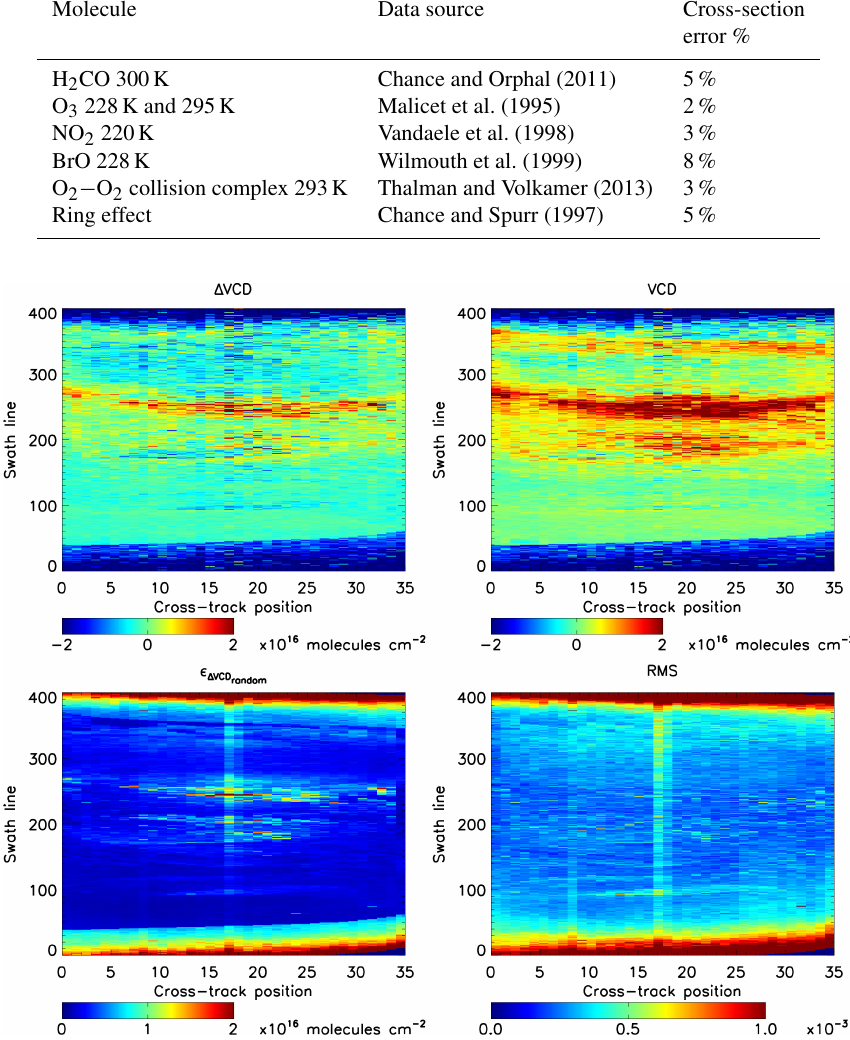
Figure 4. Africa and Europe overpass: retrieval for orbit 6202 during January 2013. VCDs corrected with the reference sector from the Ocean Pacific are depicted in top right panel while original (cid:49) VCDs are shown in top left panel. Bottom two panels show the fitting uncertainty, which shows no effect of the SAA in contrast to those shown in Fig. 3, and RMS values, by which is possible to see the effect of splitting the central cross-track pixel in two cross-track positions (Seftor et al., 2014).